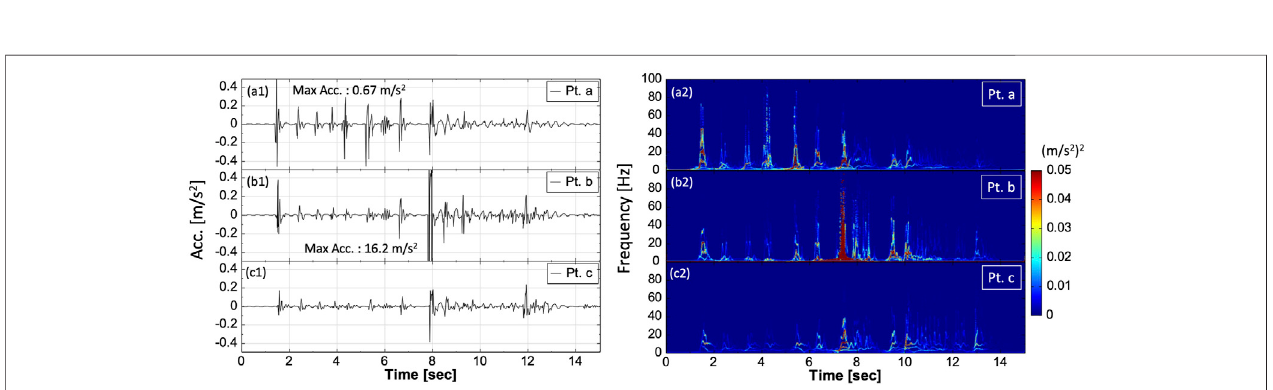
FIGURE7 | Seismic signals and their correspondingtime – frequency spectra with respect to the monitored points a, b,and cofthe single small rockfallsimulation.